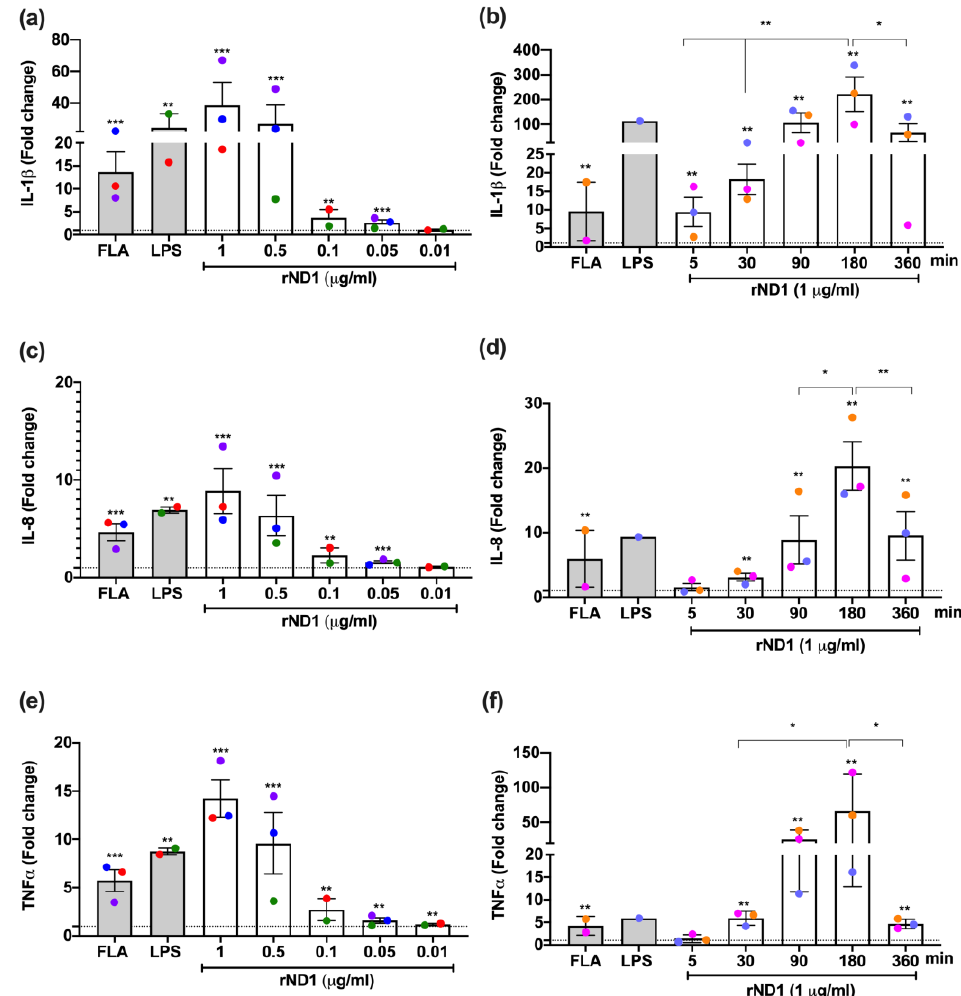
Figure 2. rND1 promotes a dose- and time-dependent in vitro pro-inflammatory response in mononuclear cells. Values of fold change were calculated from the unstimulated control after being normalized to the expression of GAPDH and β -actin; ( a , c , e ) Dose response and ( b , d , f ) Time response of mononuclear cells stimulated with rND1 for 3 h. The expression levels for IL-1 β , IL-8, TNF- α are presented as the mean ± SEM, and statistical differences from the Mann–Whitney test are shown. FLA: Flagellin from S. typhimurium (50 ng/mL); LPS: Lipopolysaccharide from E. coli k12 strain (1 µ g/mL). Color circles correspond to each event of monocytes isolation from each of the healthy volunteers in independent experiments. In all cases, the dashed line corresponds to the unstimulated control. * p < 0.05; ** p < 0.01 and *** p < 0.001.